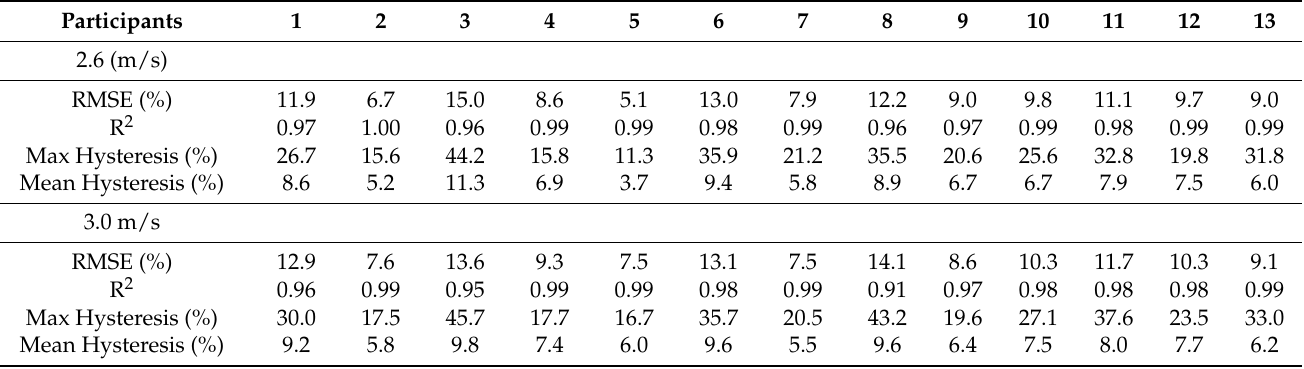
Table 3. Running testing results by subject, for the Kinetyx SI as compared to the vGRF data from the force-instrumented